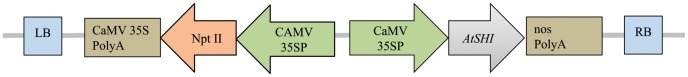
Gene construct: pKanIntron-35S-SHI used for Agrobacterium-mediated transformation of poinsettia.